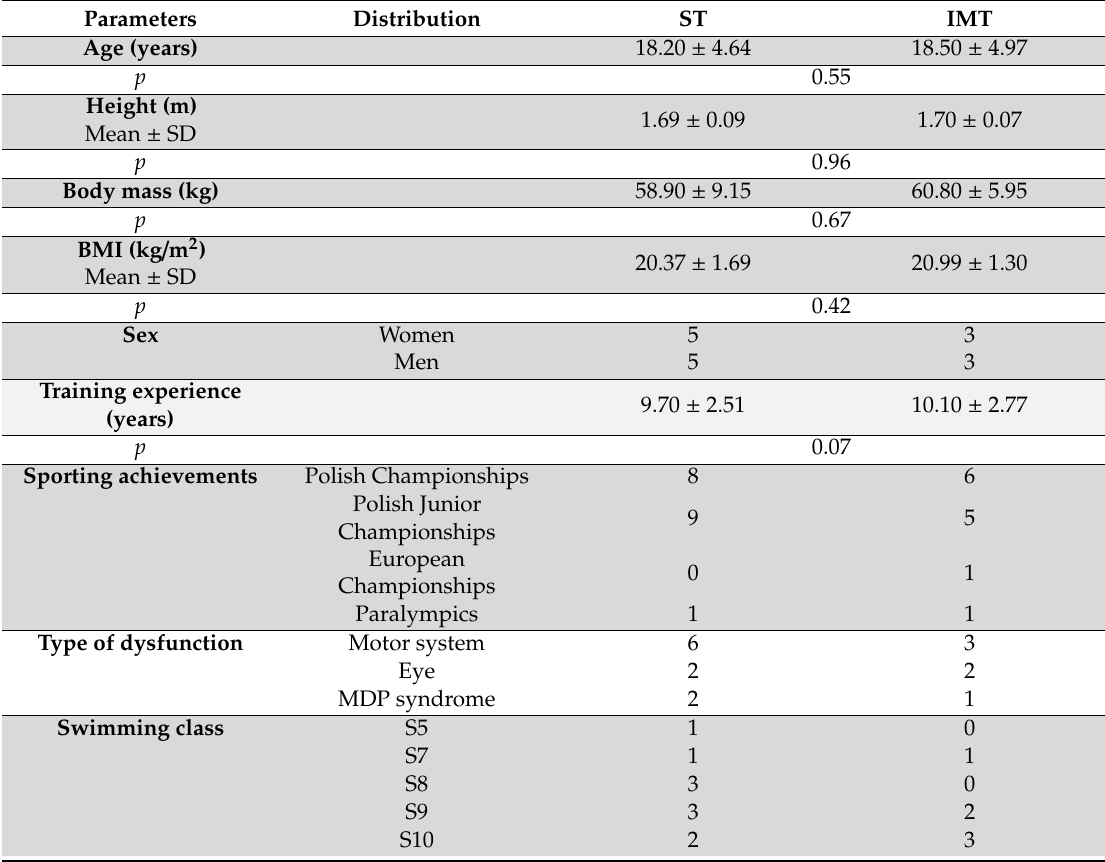
Table 1. Characteristics of the athletes in each